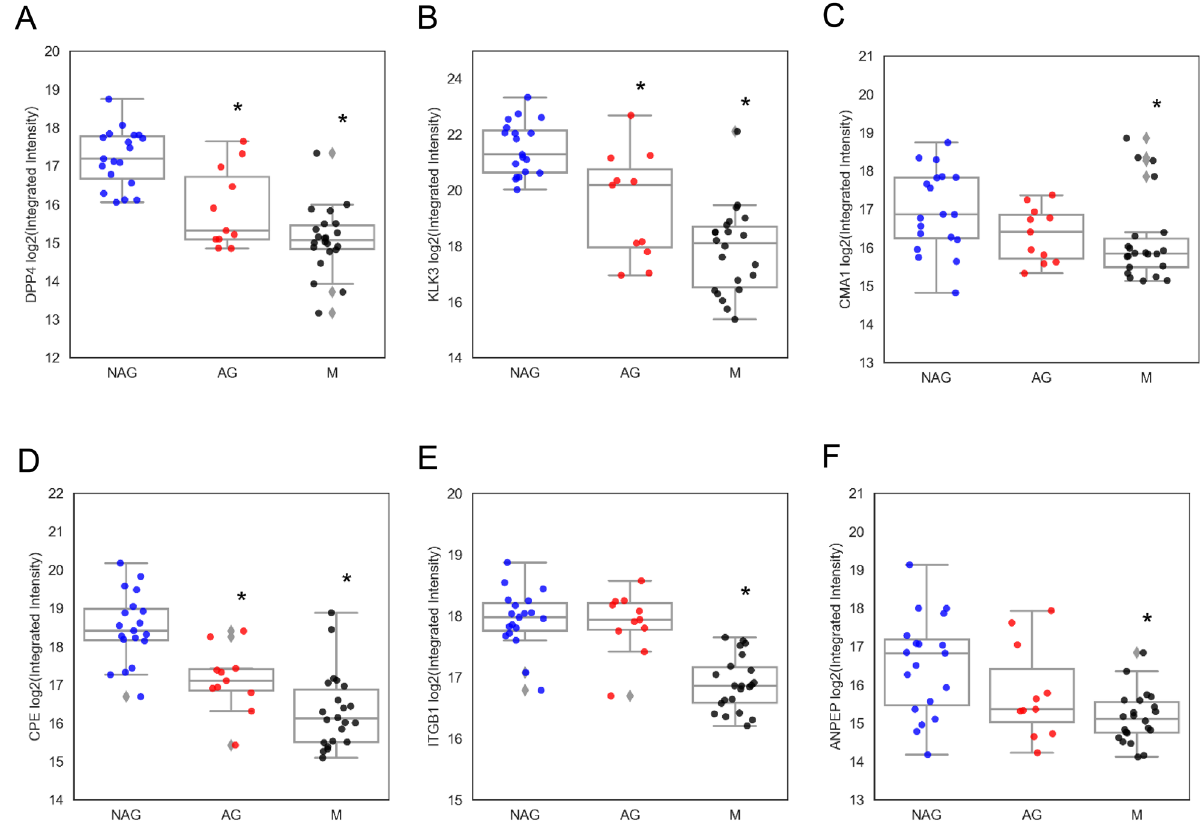
Figure 4. Verification of dysregulation of proteinases using independently collect cohort. Proteinase expression patterns of DPP4 ( A ), KLK3 ( B ), CAM1 ( C ), CPE ( D ), ITGB1 ( E ), and ANPEP ( F ) in different subtypes of tumors, including NAG, AG and metastatic PCa (M). * p <